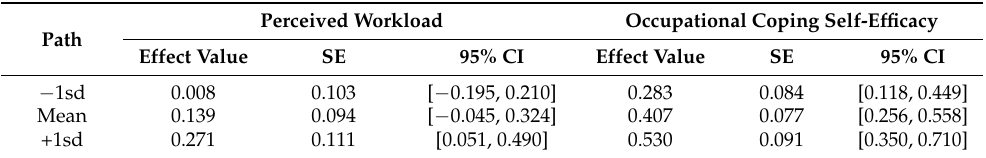
Figure 3. Moderated effect of similarity perception in the relationship between leader humor and occupational coping self-efficacy. Table 5. Simple effect analysis of moderation